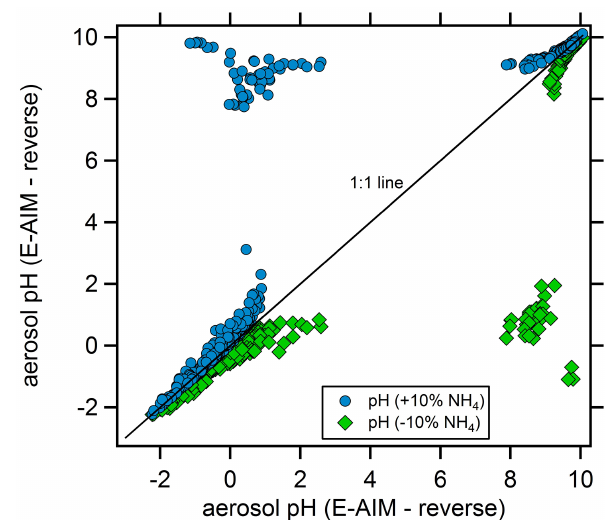
Figure 3. Sensitivity of aerosol pH predicted with E-AIM (reverse mode) to small changes in the input aerosol NH +